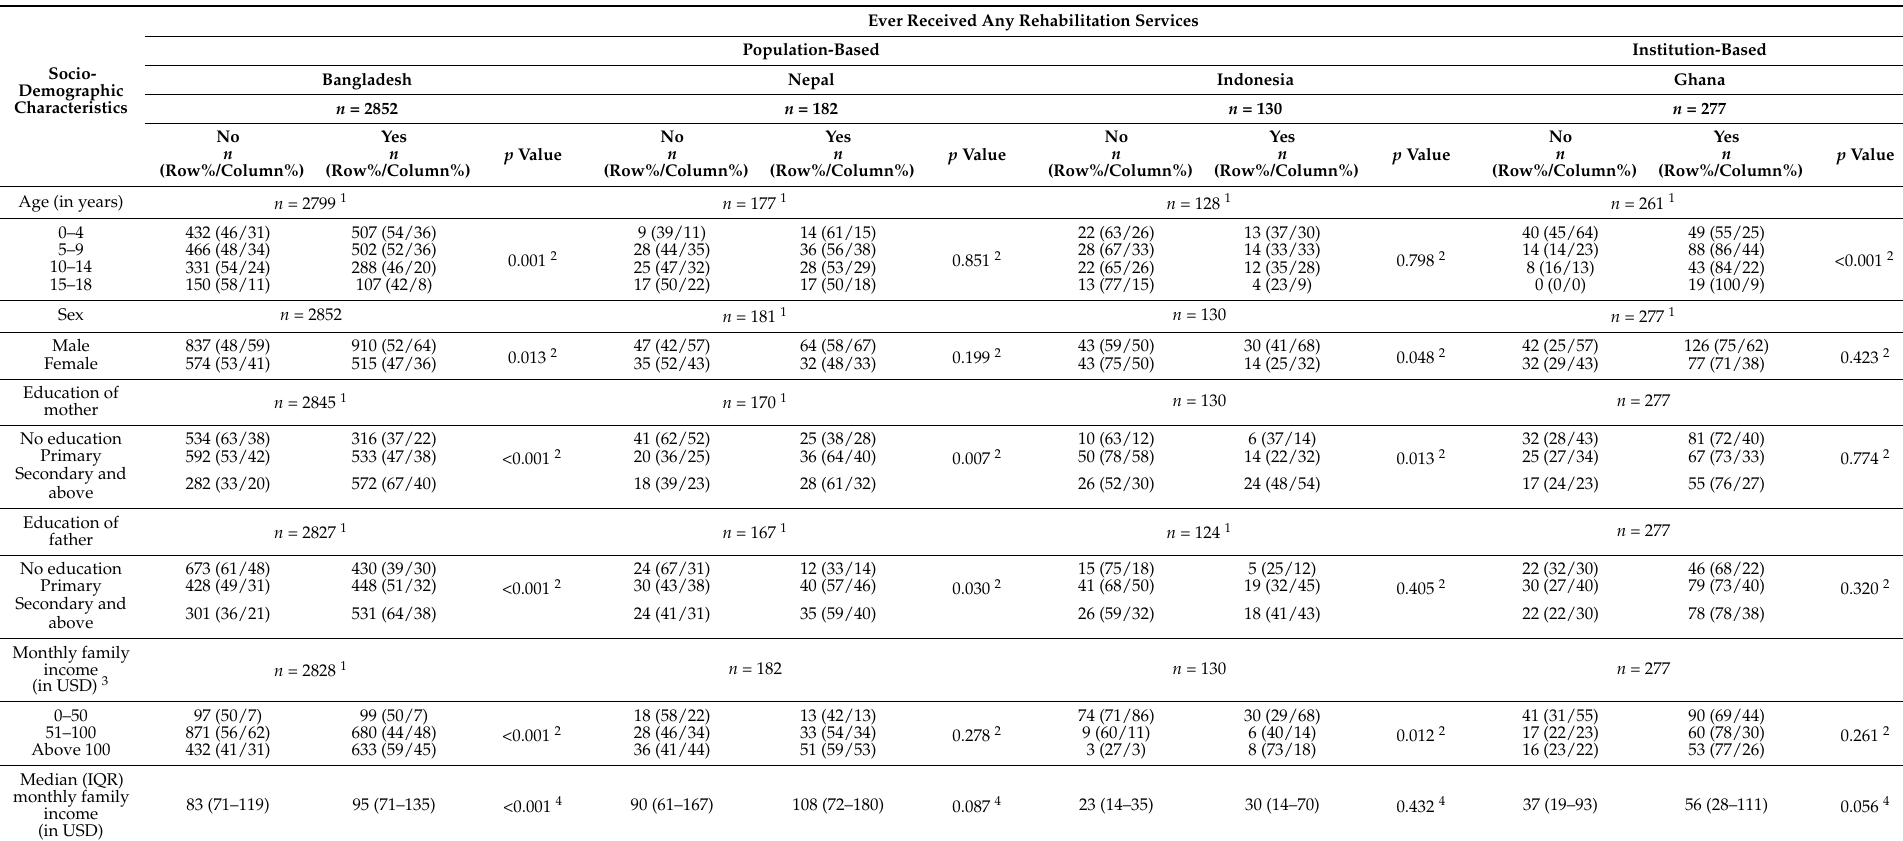
Table 2. Distribution of socio-demographic factors according to rehabilitation status of children with CP in Bangladesh, Nepal, Indonesia, and Ghana.